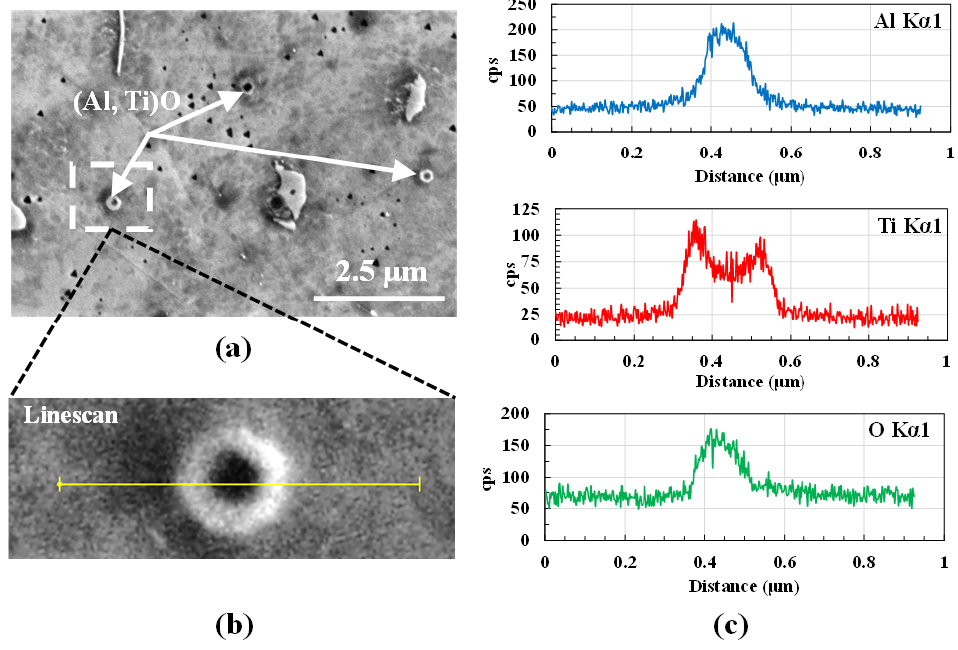
Figure 12. ( a ) SEM image of Al and Ti precipitates in the powder-fed specimen. ( b ) Zoomed image of the region where EDS line scans are taken. ( c ) Line scan profiles of Al, Ti, and O.